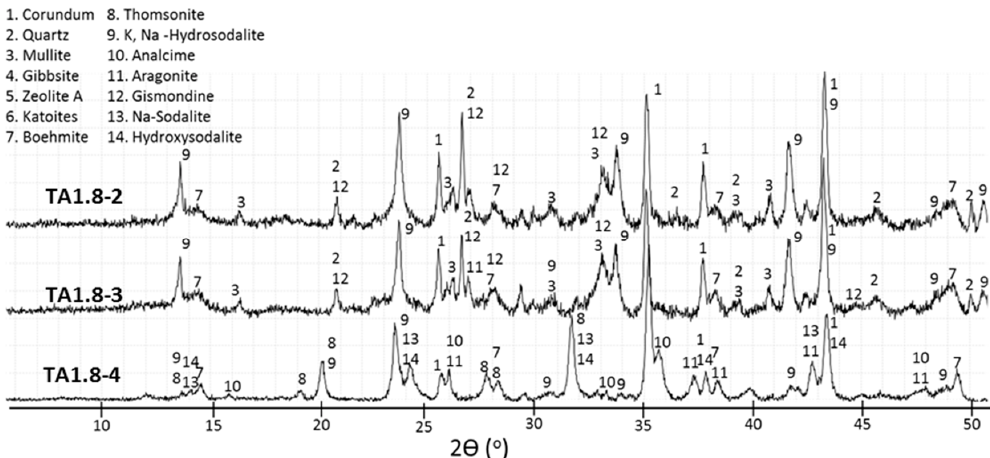
Figure 6. Diffractograms for TSRC specimen with 1% tartaric acid.